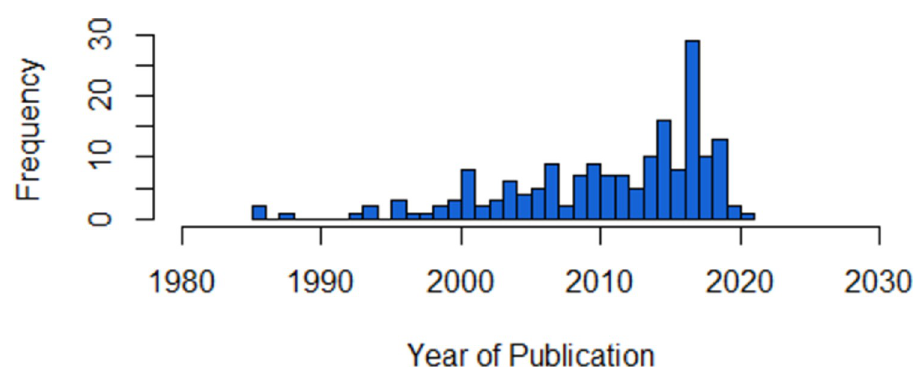
Fig 1. Comparison of publication dates of arsenic drinking water standards.